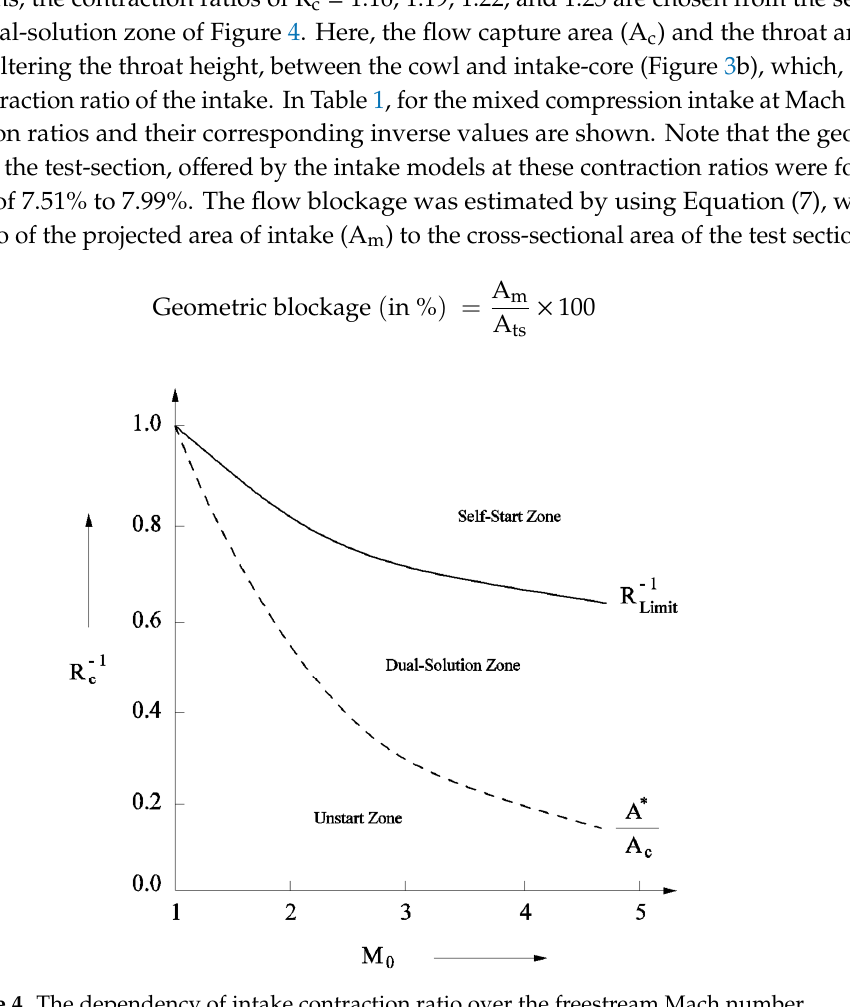
Figure 4. The dependency of intake contraction ratio over the freestream Mach number.